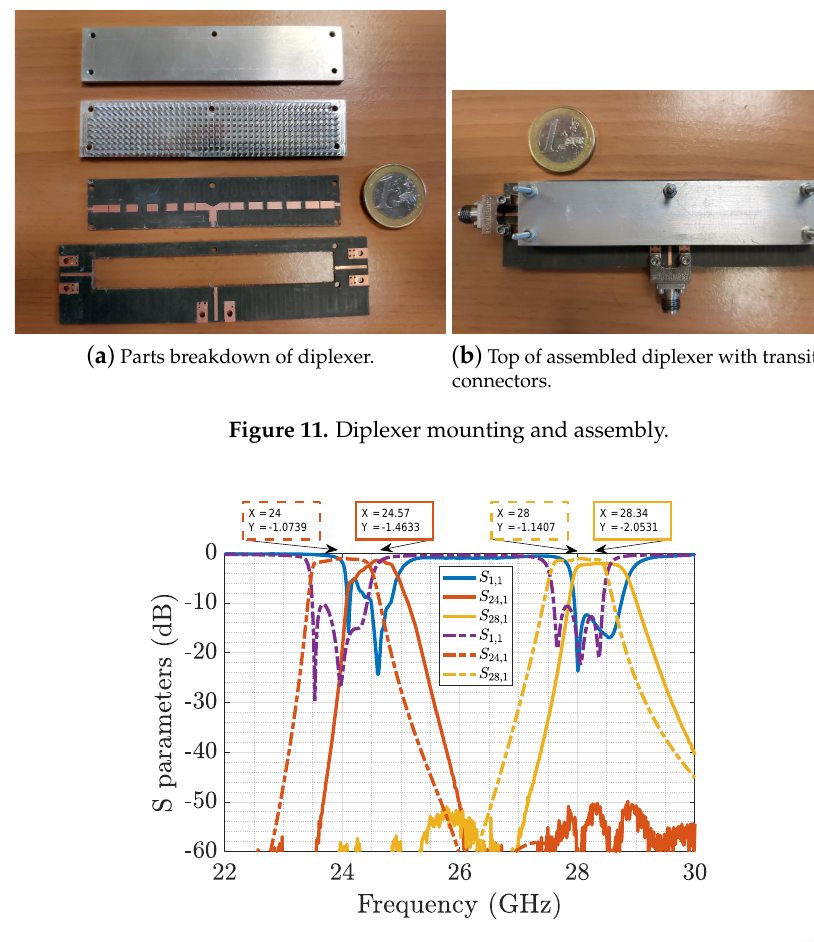
Figure 12. Measured vs simulated S-Parameters of Ka-band diplexer with RT5880 TM in inverted microstrip gap waveguide technology (pin height = 2.8 mm).